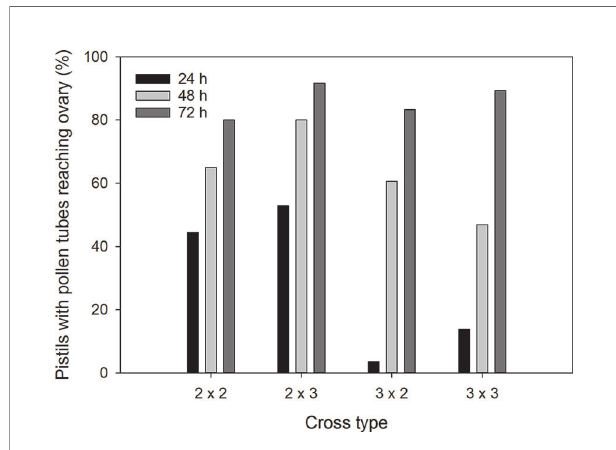
FIGURE 3 | Mean percentage of Hydrangea macrophylla fl owers with pollen tube reaching the ovaries at 24, 48, and 72 h post-pollination. 2 = 2 x = diploid; 3 = 3 x = triploid. Means are based on six crosses per cross type per time period. Error bars represent standard error of the mean. Pearson's chi- square values for association between cross type and percentage of fl owers with pollen tubes reaching the ovaries were c 2 = 30.6, p < 0.001 at 24 h, c 2 = 26.5, p = 0.001 at 48 h, and c 2 = 7.5, p = 0.60 at 72 h post-pollination.